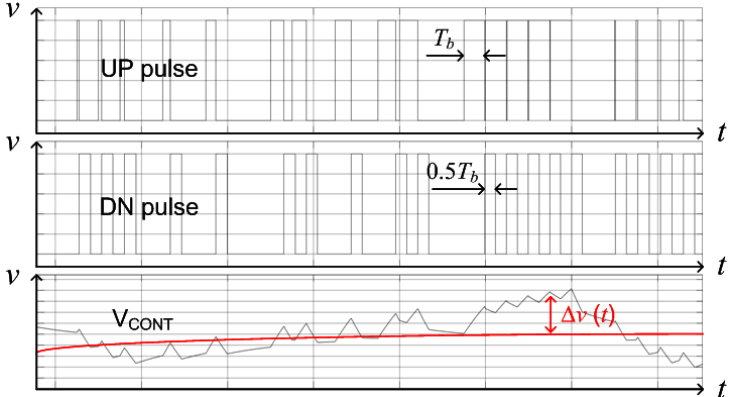
Figure 9. The simulated UP/DN pulses and V CONT voltage.